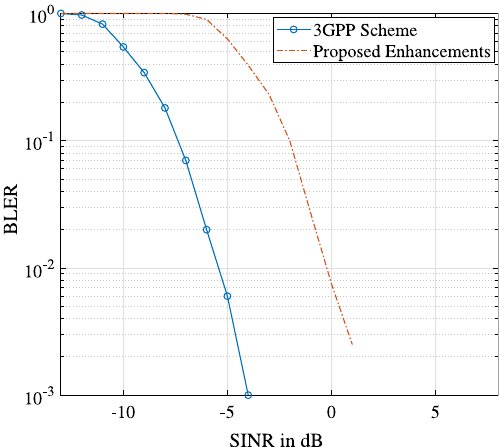
Fig. 17 eMBB evaluations used for calculating cell radius in Table 11